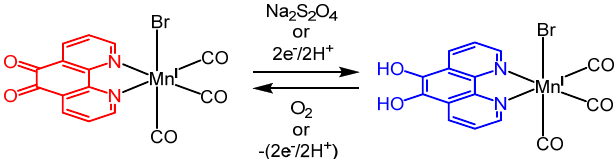
Scheme 4. Schematic representation of the chemical and electrochemical interconversions between [MnBr(CO) 3 (dpq)] and [MnBr(CO) 3 (dpc)].